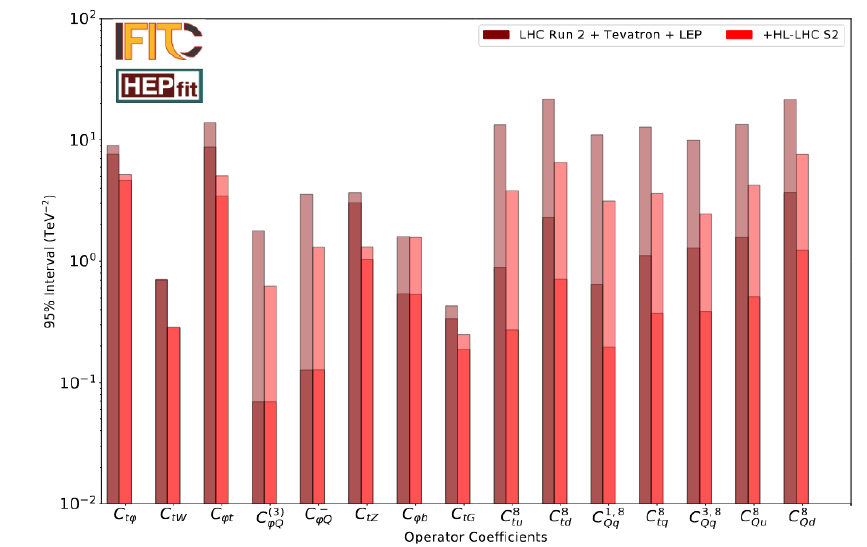
Figure 27. Comparison of expected 95% confidence intervals on Wilson coefficients for dimension-six operators affecting top-quark production and decay measurements using the LHC Run 2 dataset and the HL-LHC dataset [59]. Only linear terms proportional to Λ − 2 are accounted for in the dependence of the observables on the Wilson coefficients. The solid bars show the constraint of from the single parameter fits, while the translucent bars show the marginalised constraints from the global